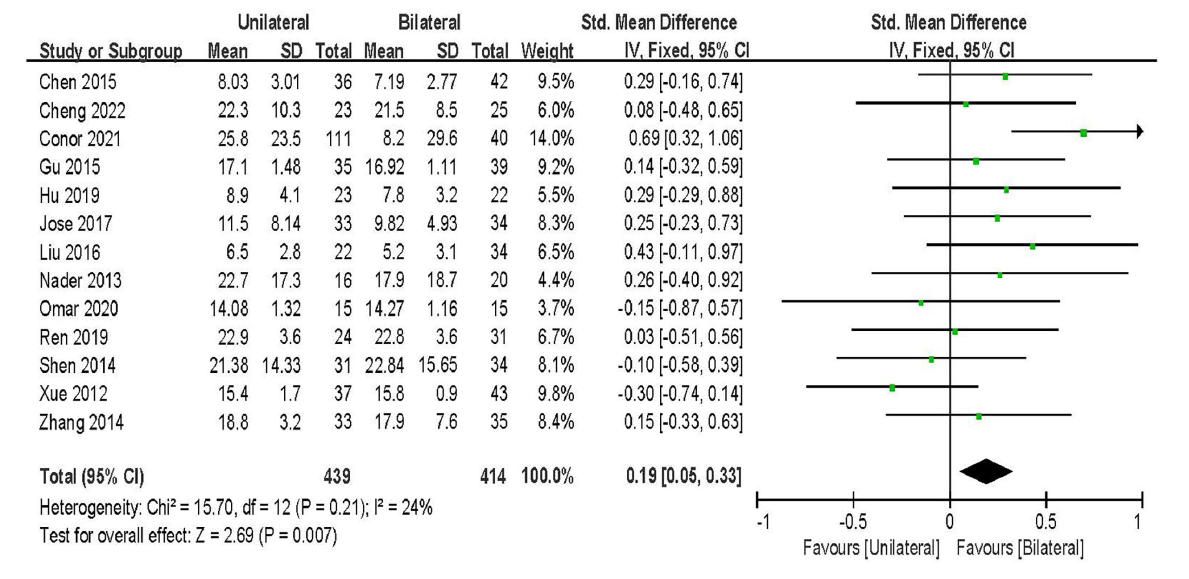
FIGURE4 Forest plot of ODI at final follow-up.